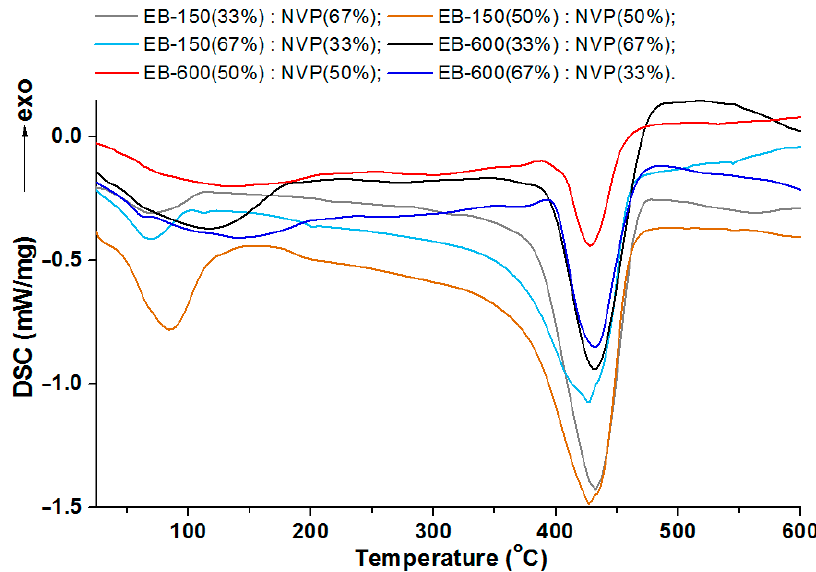
Polymers 2022 , 14 , x FOR PEER REVIEW Figure 11. DSC curves for copolymers samples. Figure 11. DSC curves for copolymers samples.